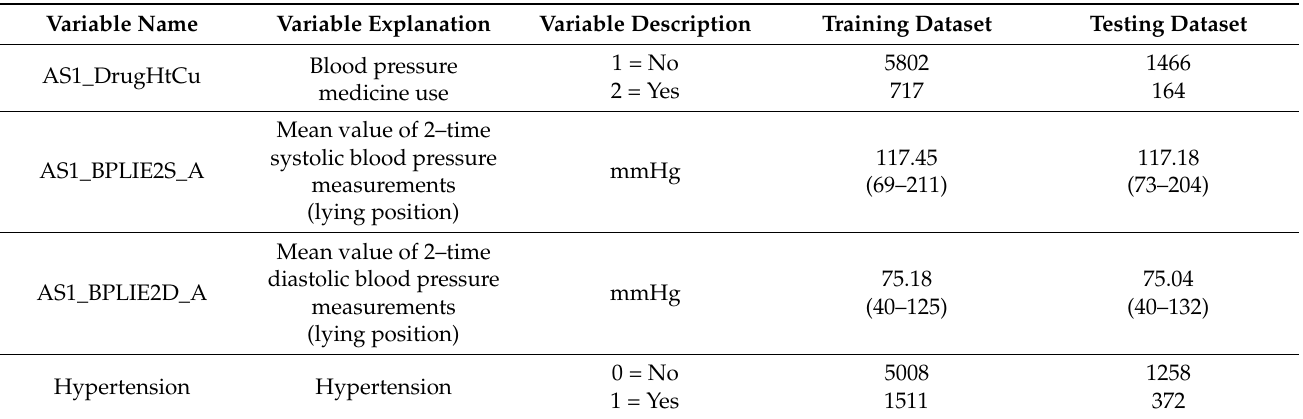
Table 3. Deriving the class of each sample, whether hypertension or not, from three dependent